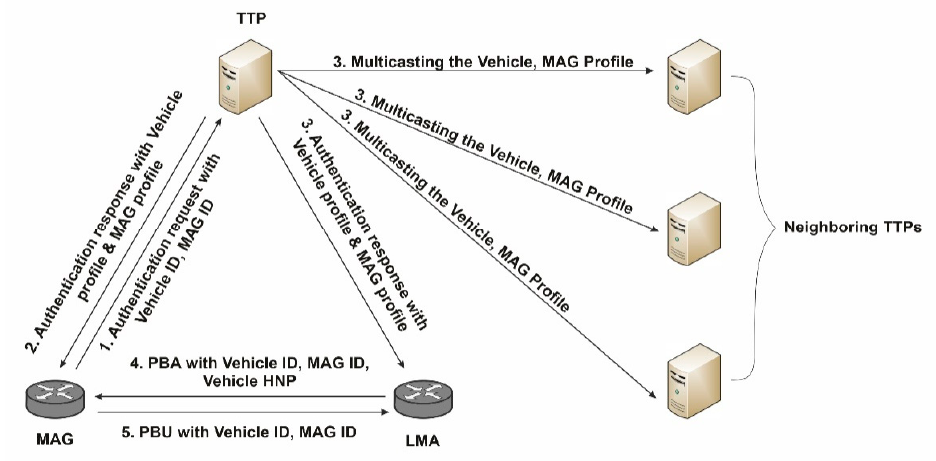
Figure 1. Multicast authentication information by TTP